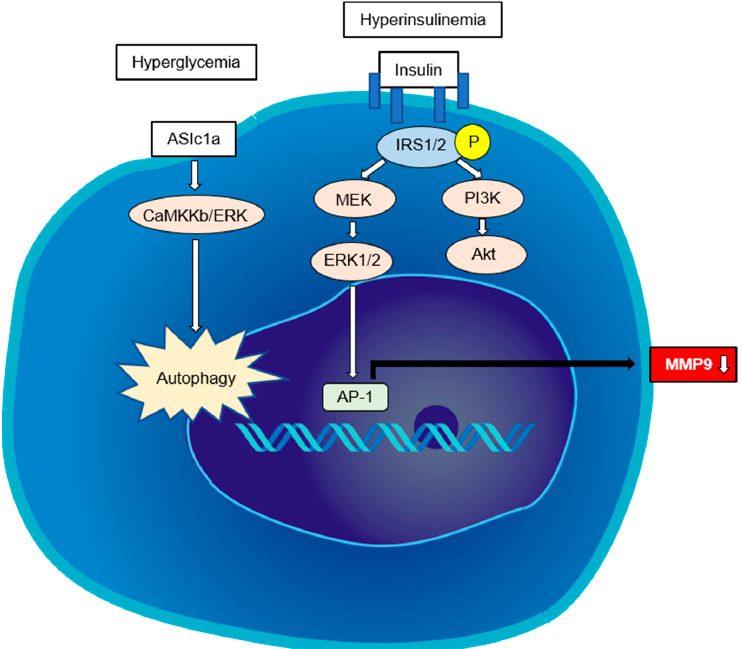
Figure 3. The direct pathways regulating HSC activation in steatohepatitis. Hyperinsulinemia can directly stimulate HSCs to proliferate and secrete type I collagen by differentially activating PI3K- and ERK-dependent pathways. IGF1R triggers ERK1/2 phosphorylation via IRS2, leading to the expression of matrix metalloproteinase (MMP)-9. Hyperglycemia can aggravate hepatic fibrosis, which may be associated with the HSC autophagy induced by acid-sensing ion channel 1a (ASIC1a).